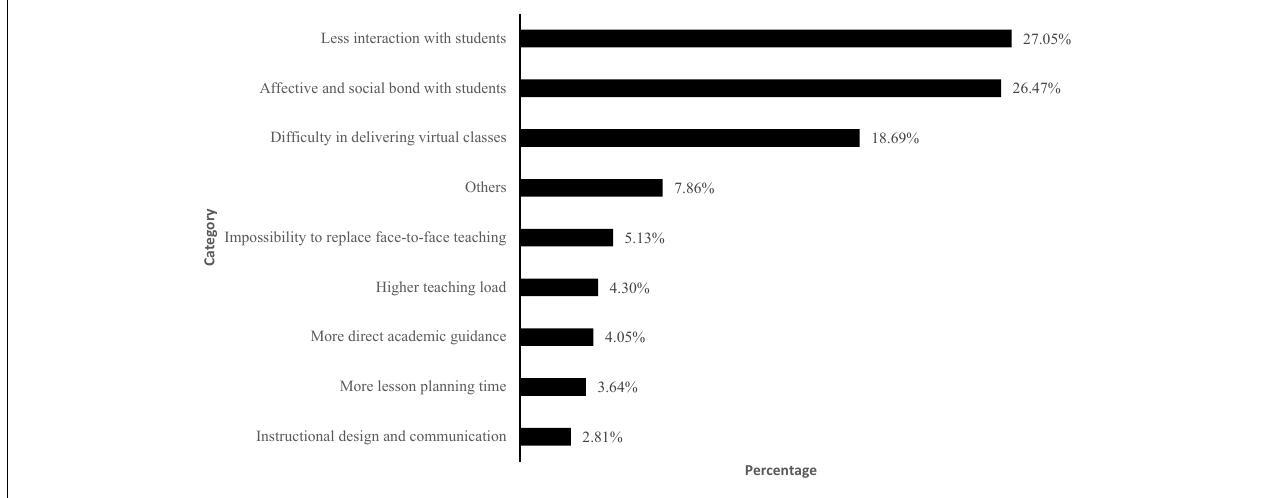
FIGURE 1 | Main changes in teaching practices ( n = 1209). Less interaction with students includes less feedback, efficiency and dynamism with families and students, and no motivation (12.49%), difficulty for checking students’ progress (7.86%), and difficulty for contacting students’ families (6.7%). Difficulty in delivering virtual classes includes difficulty in proposing practices and explaining the subject (11%), and ICT dependency (7.69%). Higher teacher load refers to poor work-life balance, less privacy, lack of specific work schedule (reply to emails outside of working hours). Others includes categories with a presence lower than 2%: reaching students with different needs (1.99%), responding to students’ self-learning (1.41%), responding to students’ questions in class (1.08%), more flexible schedules (0.91%), opportunity to innovate in the subject (0.83%), more feedback (0.74%), no changes (0.58%), and unclassifiable answer